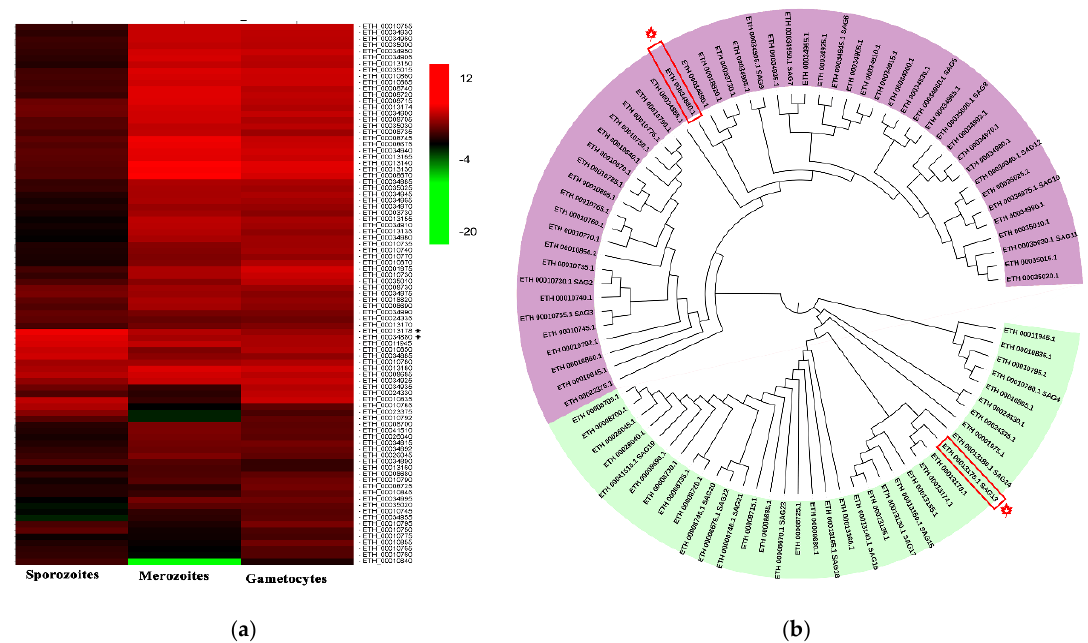
Figure 2. Expression profile and evolutionary analysis of E. tenella SAG proteins. ( a ) Transcription levels of surface antigen (SAG) genes in sporozoites, merozoites and gametocytes were obtained from ToxoDB. The heatmap of the expression profile is drawn. Et-SAG and Et-SAG13 are indicated with asterisks (*). ( b ) The amino acid sequences were downloaded from ToxoDB. A phylogenetic tree was constructed using the neighbor-joining method in MEGA software (version 5.05). Et-SAG and Et-SAG13 are indicated with asterisks (*). The light purple and light green represent different branches of the SAG family.